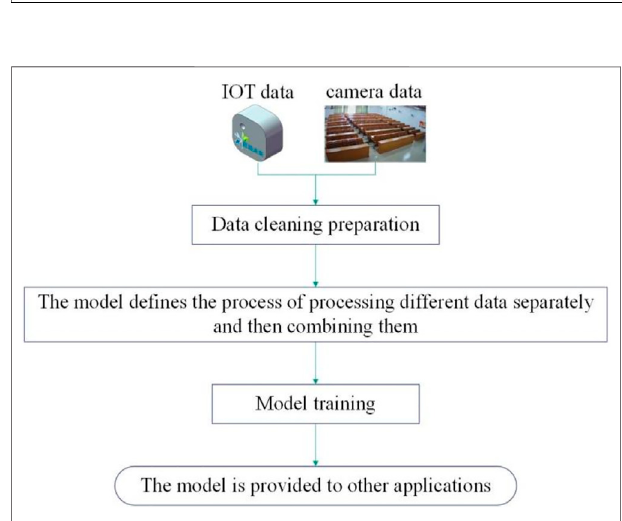
FIGURE 3 | Thermal model learning